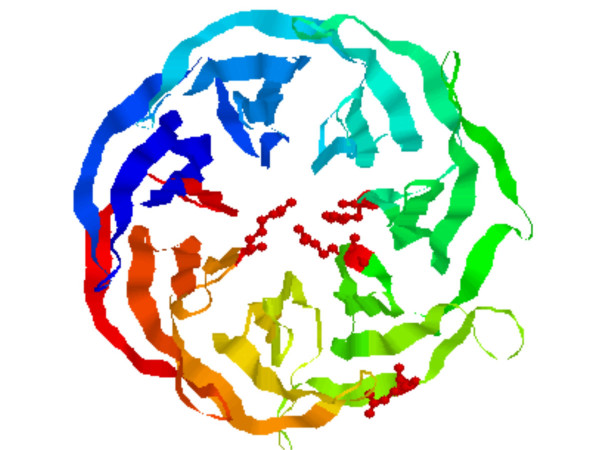
Homology model of Bfl341 protein. (template:1RI6; putative isomerase YbhE of E. coli). The β-propeller found in 1RI6 [24] is also evident in the homology model (starting from residue 1, a Met in Bfl341). Important predicted catalytic residues outline the substrate cleft. These are His 130, Arg 180, Glu 217 and Arg 281 of Bfl341 corresponding to His 148, Arg 196, Glu 212, and Arg 274 in the template structure (four from five conserved residues known for the family and those checked from N.crassa by mutagenesis to be important for catalysis in vitro [24]). Kajander et al. [24] did not know yet the accurate molecular function of the E.coli structure they solved. However, regarding the high sequence similarity of Bfl341 (38% identical, 57% similar residues) to recently characterized E.coli Pgl protein [25], the actual activity of Bfl341 we now predict to be a 6-phosphogluconolactonase.